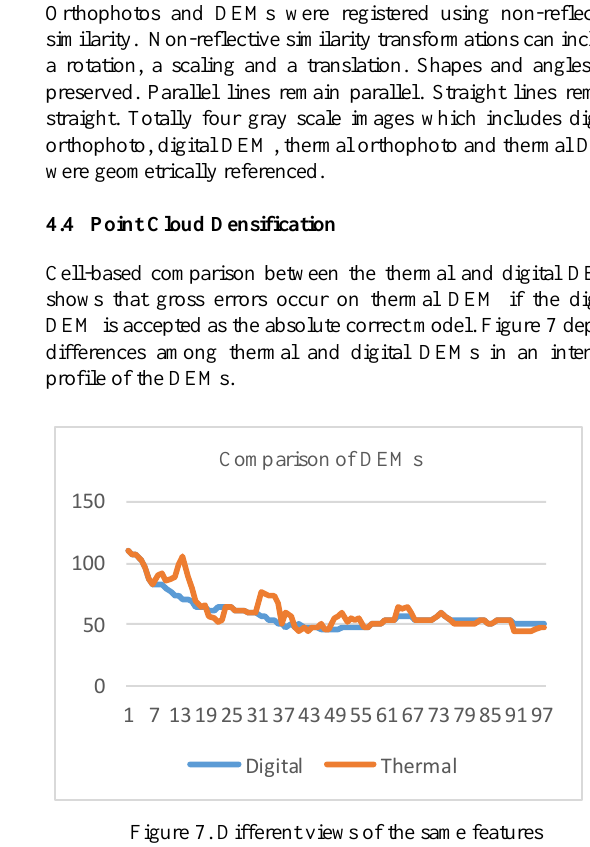
Figure 7. Different views of the same